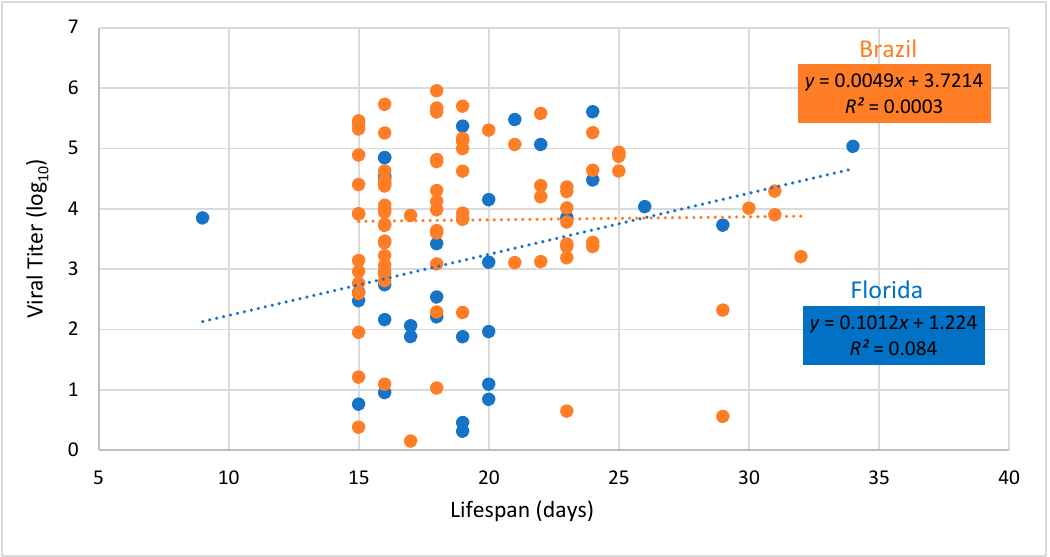
Figure 5. Body viral titer and lifespan of female Aedes aegypti from Brazil and Florida infected with Mayaro virus. Dashed lines drawn through viral titer values show the best fit for Brazil and Florida. Adult lifespan is measured from date of eclosion to death.